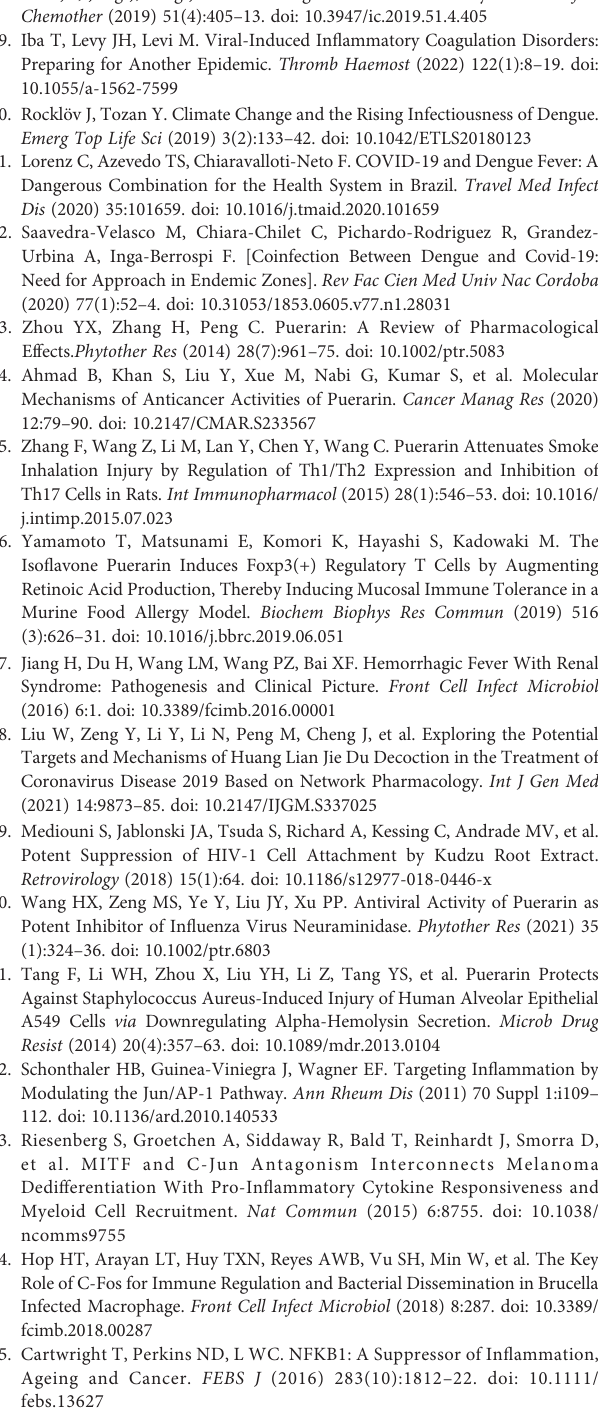
Supplementary Table 5 | PPI network of common genes. Supplementary Table 6 | GO term enrichment analysis of common genes. Supplementary Table 7 | KEGG pathway analysis of common